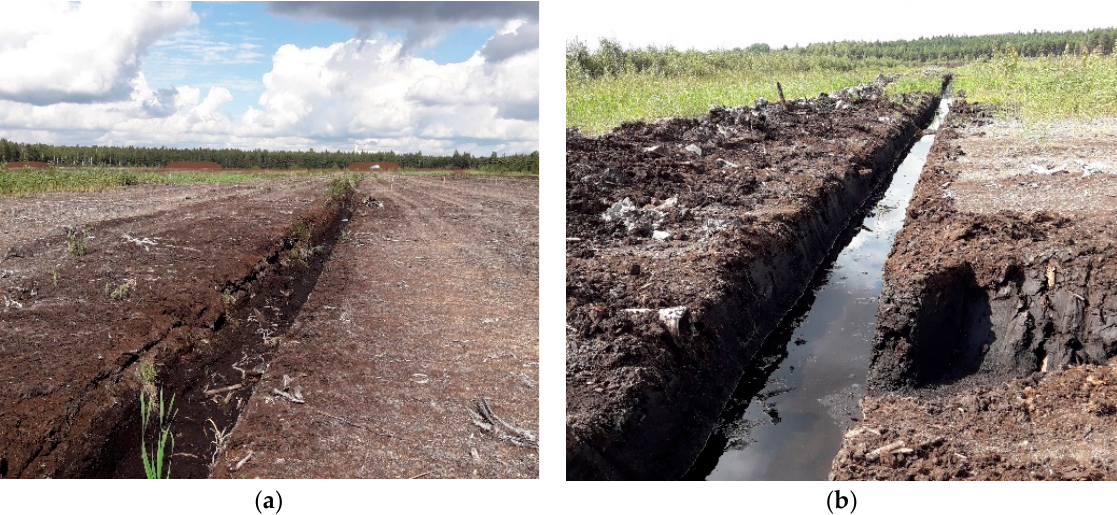
Figure 1. Drainage ditch in the study site: ( a ) drainage ditch before cleaning; ( b ) drainage ditch after cleaning.